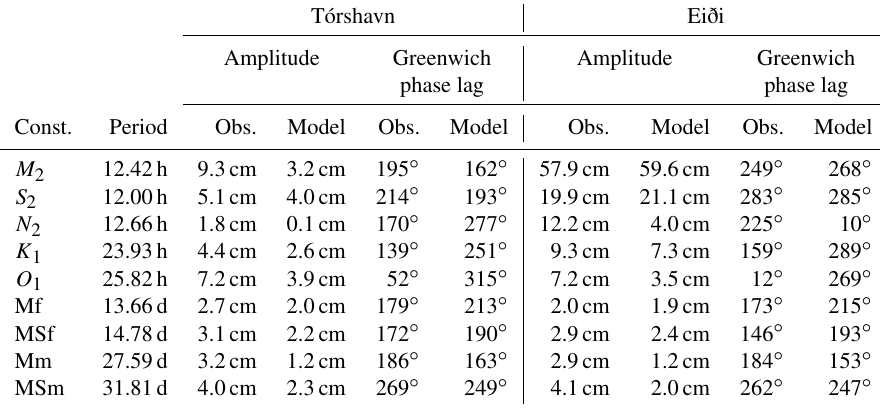
Table 1. Amplitudes and Greenwich phase lags, as determined by harmonic analysis, for nine tidal constituents (Const.) of sea level variation at two locations (Tórshavn and Eiði, Fig. 1a) as observed at tide gauges (Obs.) and as simulated at grid points close to the locations by the 800m parent model (Model). The harmonic analysis was for the period 1 January to 1 October 2013 for both the observed and the simulated sea level. For the semidiurnal and diurnal constituents, the periods are listed in hours (h). For the long-period constituents, they are listed in days (d). Tórshavn Eiði Amplitude Greenwich Amplitude Greenwich phase lag phase lag Const. Period Obs. Model Obs. Model Obs. Model